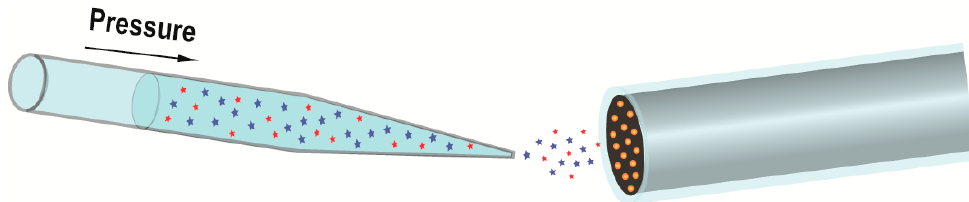
Figure 3. A schematic of the experimental set-up for comparing the kinetic response for detection of glucose (red stars) and dopamine (blue stars) using the glucose oxidase and gold nanoparticle modified carbon fiber microelectrode (GOx–AuNP–CFME). Here a micropipette filled with a solution mixture containing dopamine (20 µ M) and glucose (25 mM) is placed approximately 30 µ m from the surface of a GOx–AuNP–CFME. Using a microinjector pump, 500 ms puffs of the solution mixture is injected against the sensor surface placed in buffer solution creating a controlled rapid fluctuation of the two analytes towards the electrode. By applying a potential of +0.5 V and − 0.5 V to the sensor surface (vs. an Ag/AgCl reference electrode) the dopamine and glucose are amperometrically detected, through a reduction or oxidation reaction,